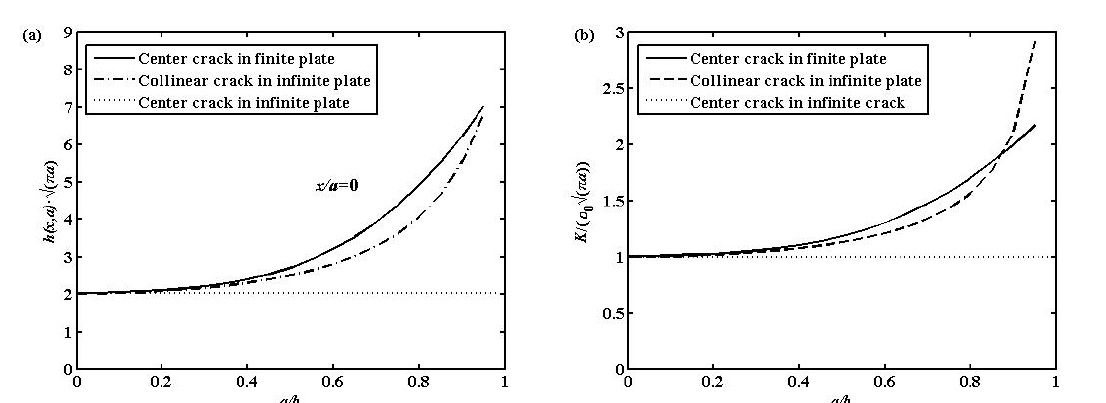
Figure 3: Comparisons of collinear cracks and center crack (a) weight function variation; (b) SIF variation.